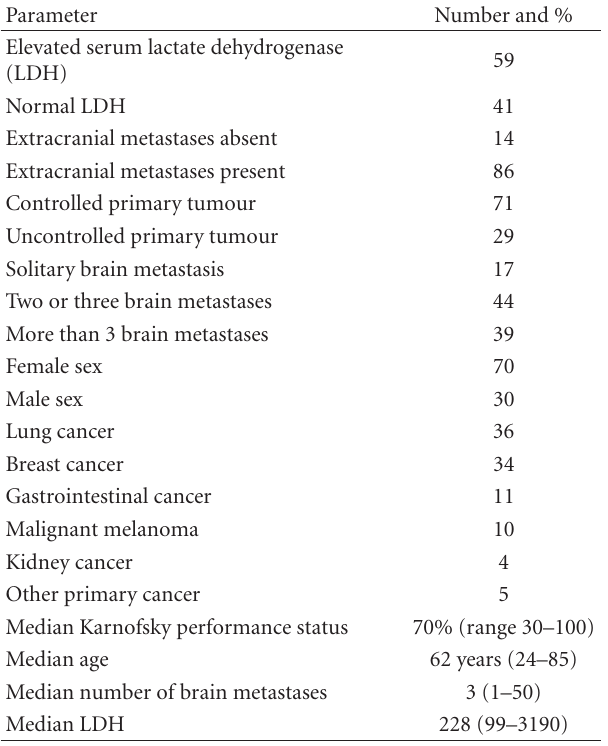
Table 1: Pretreatment characteristics of all 100 patients included in this